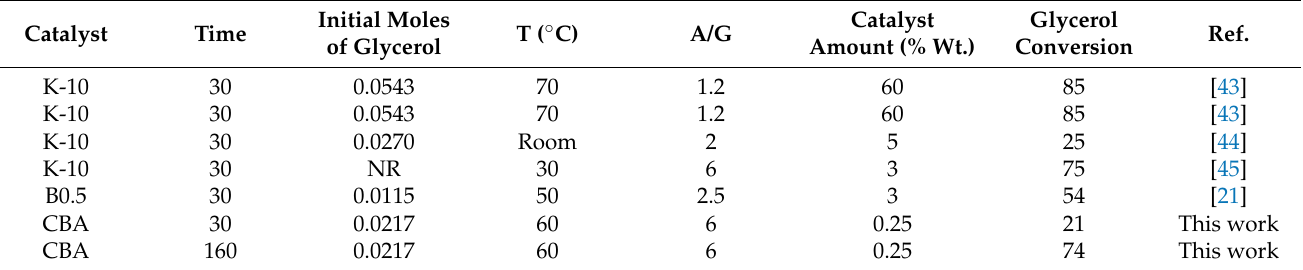
Table 5. Comparison of the experimental results obtained by different